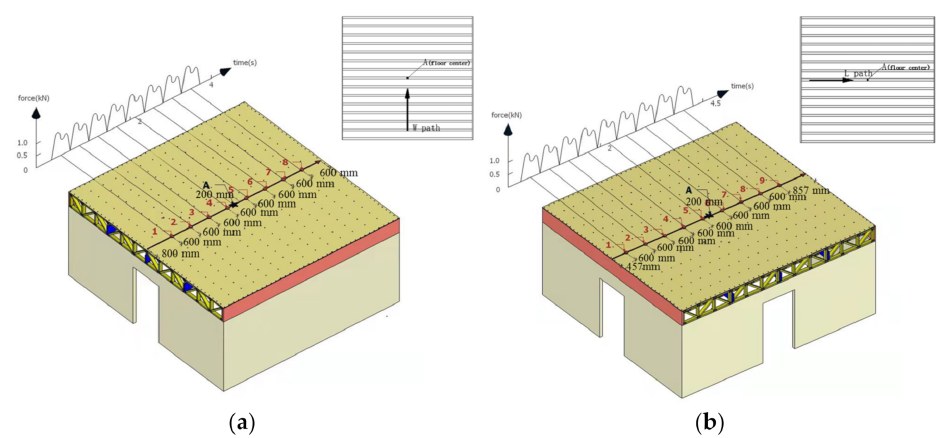
Figure 6. Walking direction and path: ( a ) perpendicular to the joist direction (W path); ( b ) parallel to the joist direction (L